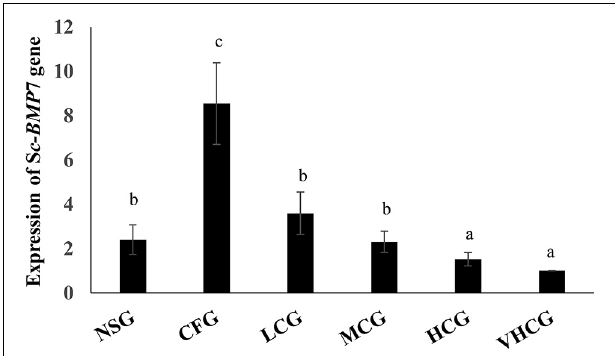
FIGURE 4 | Quantitative expression analysis of Sc-BMP 7 in seawater with different Ca 2 + concentration. Different letters represent significant differences, P < 0.05. NSG: normal seawater group; CFG: calcium free group, add EDTA-Na 2 to a final concentration of 250 mg/L; LCG, MCG, HCG, and VHCG represent CaCl 2 added to final Ca 2 + concentrations of 100, 200, 300, and 400 mg/L,